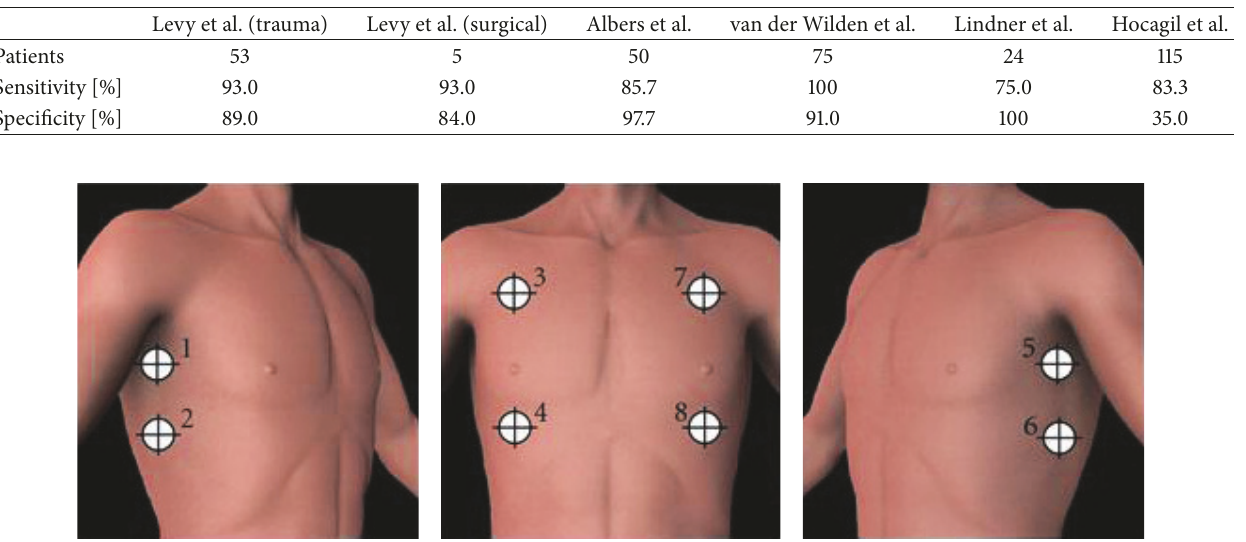
Figure 1: Scan locations of PneumoScan.